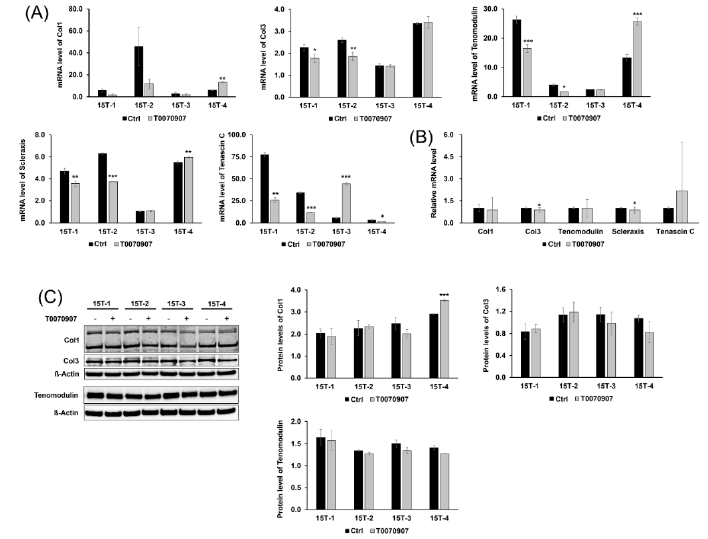
Figure 5. E ff ect of T0070907 on tenogenic di ff erentiation and regenerative capacity of TDSCs. ( A ) mRNA levels of collagen type I, collagen type III, tenomodulin, scleraxis, and tenascin C were measured by qRT-PCR. ( B ) T0070907 were not increased mRNA levels of tenogenic markers. The relative mRNA level represents the value divided mRNA level of the T0070907 treatment group by mRNA level of the control group in the all of the cells. ( C ) Western blot analysis was used to measure protein levels of collagen type I, collagen type III, and tenomodulin. T0070907 had no e ff ects on tenogenic di ff erentiation